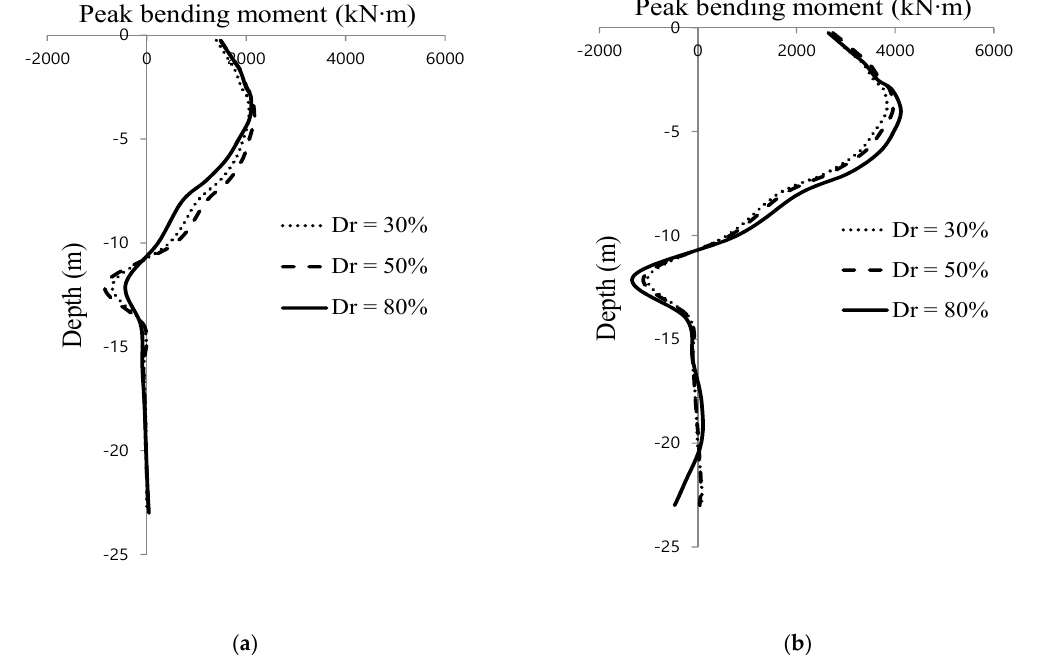
Figure 15. Peak bending moment envelopes obtained from three different relative densities. ( a ) Input acceleration: 0.13 g; ( b ) Input acceleration: 0.25 g.